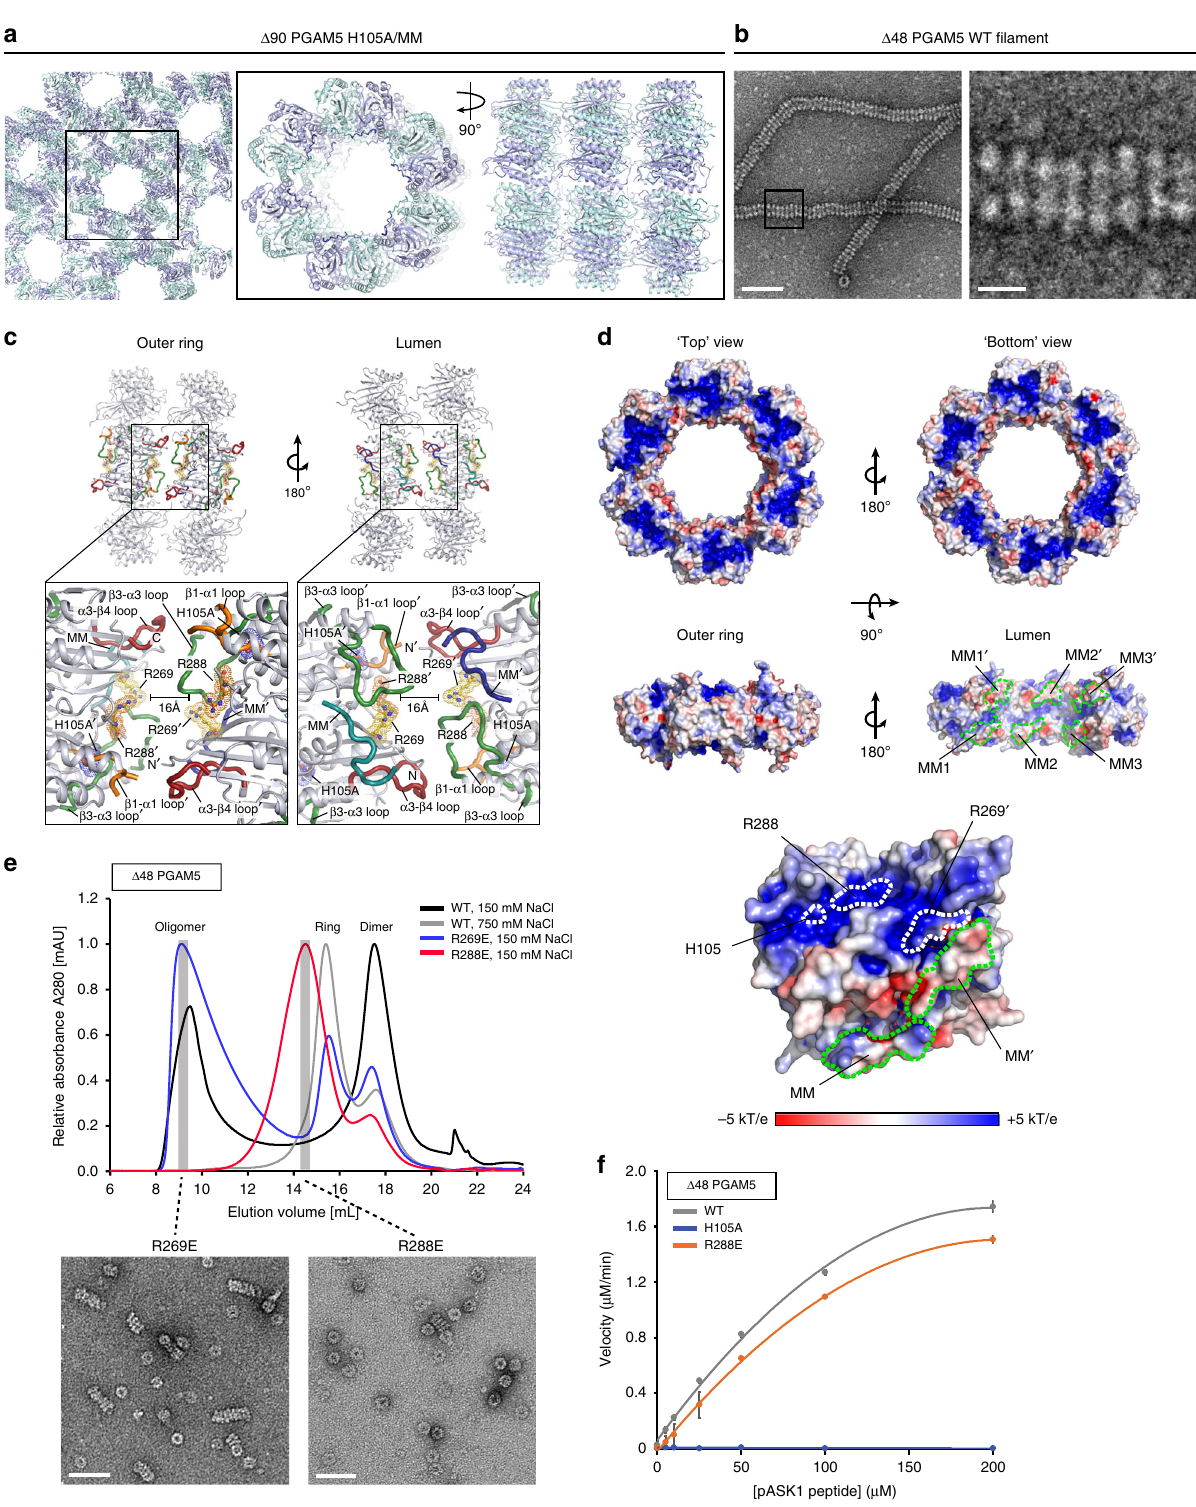
To visualize PGAM5 fi laments in cells, we focused on cytosolic cleaved PGAM5 due to resolution limits preventing the distinction between membrane-tethered and cleaved PGAM5 molecules in the mitochondrial intermembrane compartment. To increase the pool of the cleaved cytosolic PGAM5, we expressed and imaged myc-tagged Δ 23 PGAM5 (residues 24 – 289), mimicking the cleaved version, in COS7 cells using confocal